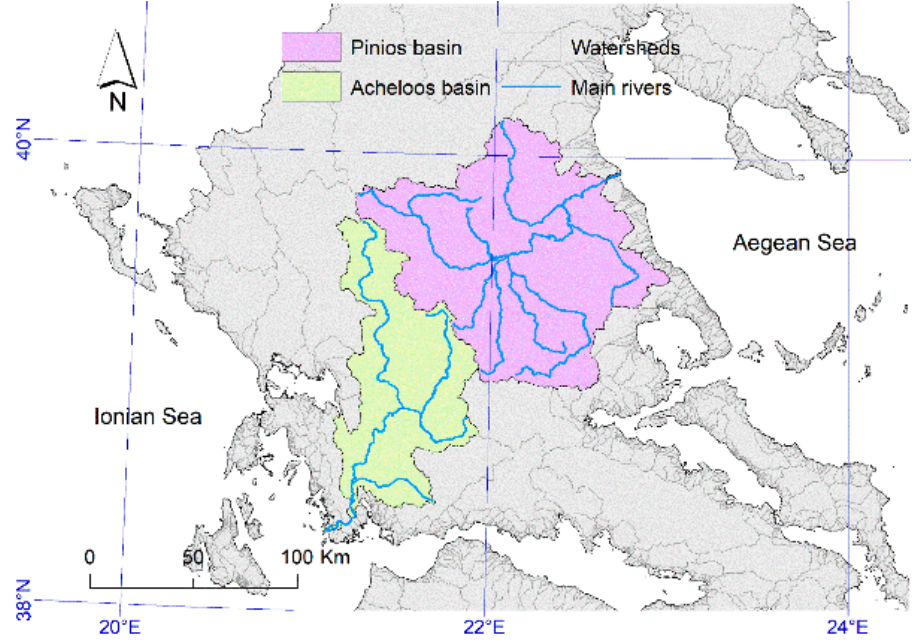
Figure 3. The study areas of the Pinios and Acheloos river basins in Greece and their main river network (source: Catchment Characterisation and Modelling, CCM—River and Catchment Database for Europe).